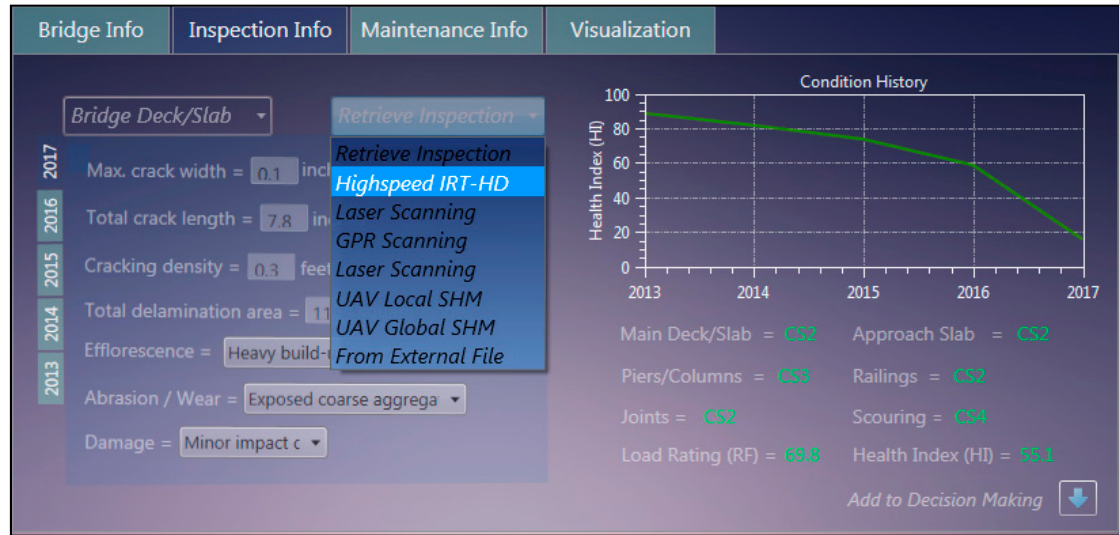
Figure 7. Web-based implementation analyzing historical NDE data.